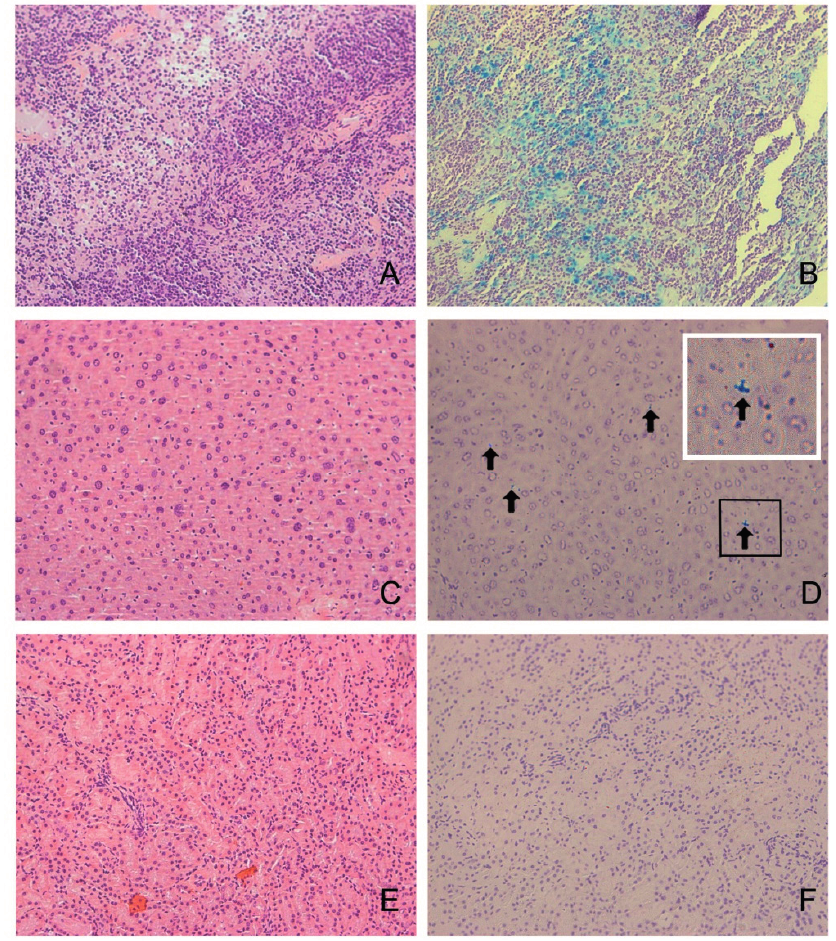
Figure 6. Histologic results of the spleen, liver, and kidney (×200). ( A , B ) HE staining and Prussian blue staining of the spleen. High levels of iron uptake were observed in the spleens; ( C , D ) HE staining and Prussian blue staining of the liver. A low level of iron uptake (arrows) was seen in the liver. White line box is the enlarged picture of black line box; ( E , F ) HE staining and Prussian blue staining of the